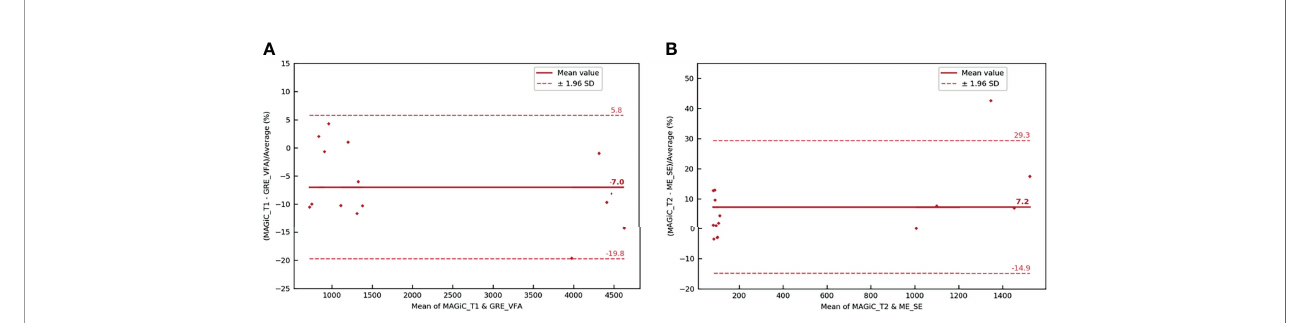
FIGURE 8 | Bland – Altman graph representing the relative difference (in percent) between the T 1 (A) and T 2 (B) maps with the MAGIC ® method and conventional sequences for the fi ve patients scanned on the brain with the head and neck unit (HNU) coil. The red solid line marks the mean of the difference; the red dotted lines mark the mean ± 1.96 standard deviation of